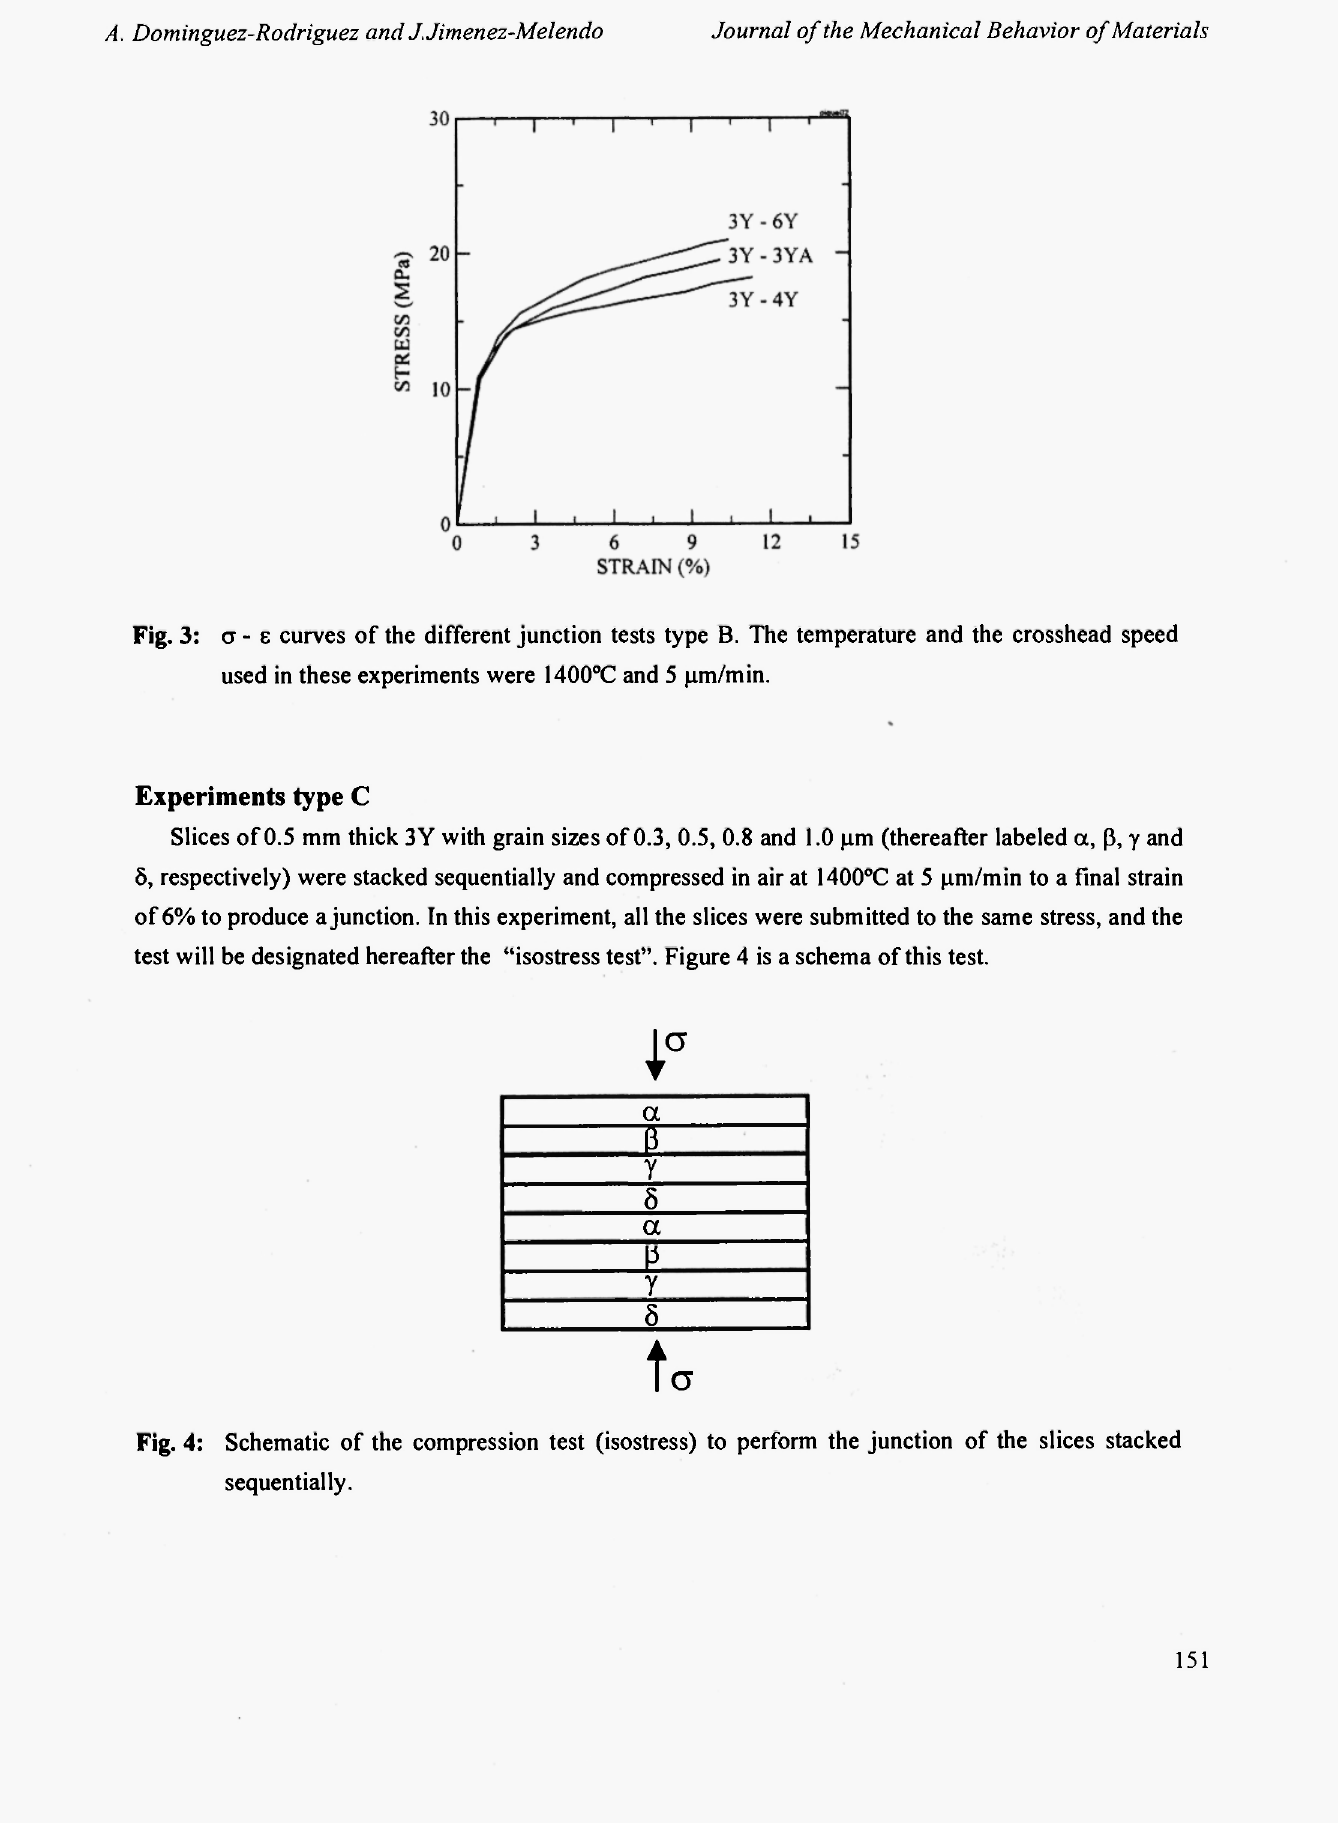
Fig. 4: Schematic of the compression test (isostress) to perform the junction of the slices stacked